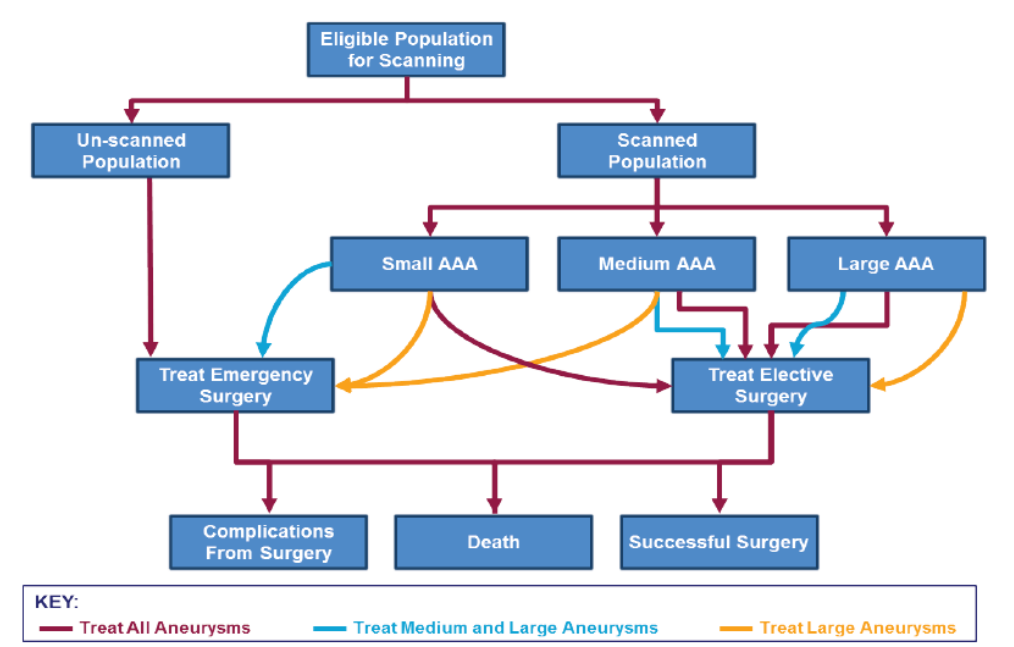
Figure 2. Decision Model Scenario